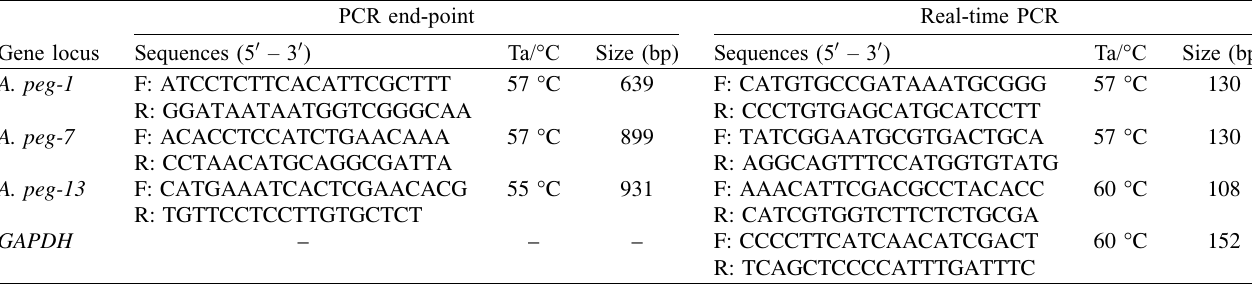
Table 1. Primer sequences of target genes coding for antigenic proteins, used in this